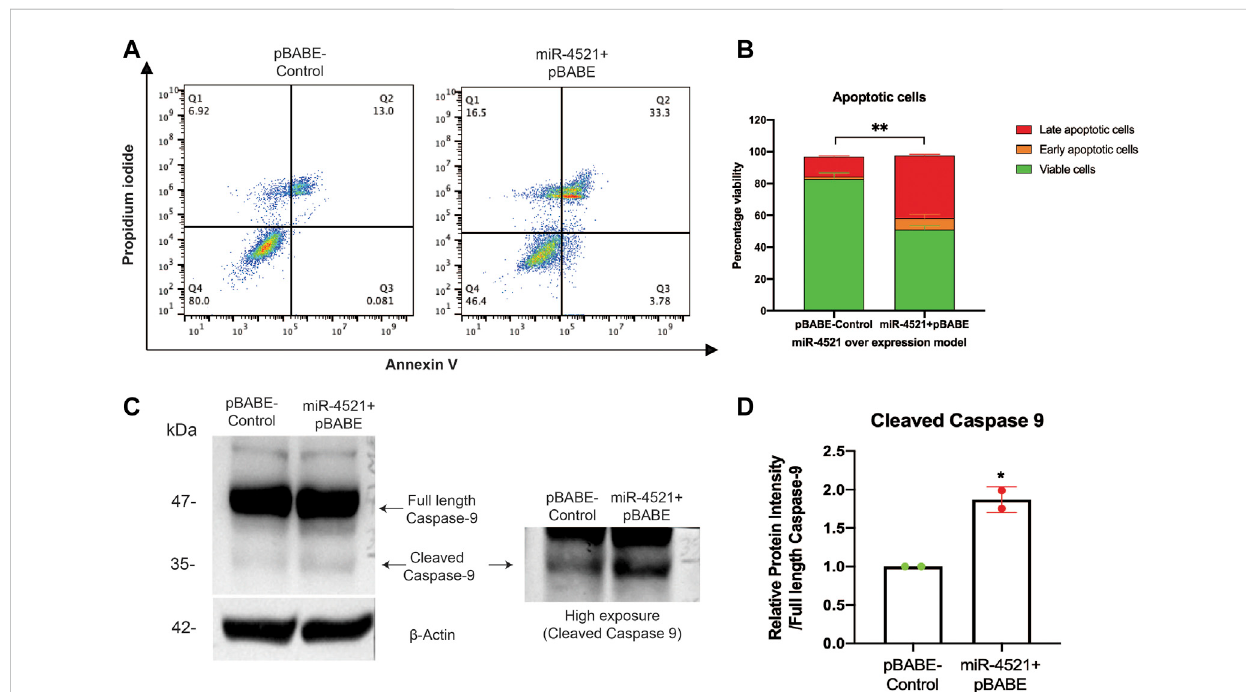
FIGURE 6 miR-4521 overexpression contributes to impaired DNA damage response and apoptosis in breast cancer cells. (A) Apoptosis analysis of Annexin V and propidium iodide (PI) stained control and miR-4521 over expressing cells. FACS analysis was performed against Annexin V-Alexa Fluor 488 and PI positive cells, where cells positive for both the stains were considered as late apoptotic cells while, cells only positive for Annexin V was considered early apoptotic cells; paired Student ’ s t-test (two-tailed) was performed between control and miR-4521 over expression groups for each stage of apoptotic groups; ** p < 0.001, ( n = 3). (B) miR-4521 overexpressing cells showed signi fi cant increase in early and late apoptotic cells due to increased ROS induced DNA damage, and impaired DNA damage response when compared with control cells (C) Western blot analysis of apoptotic